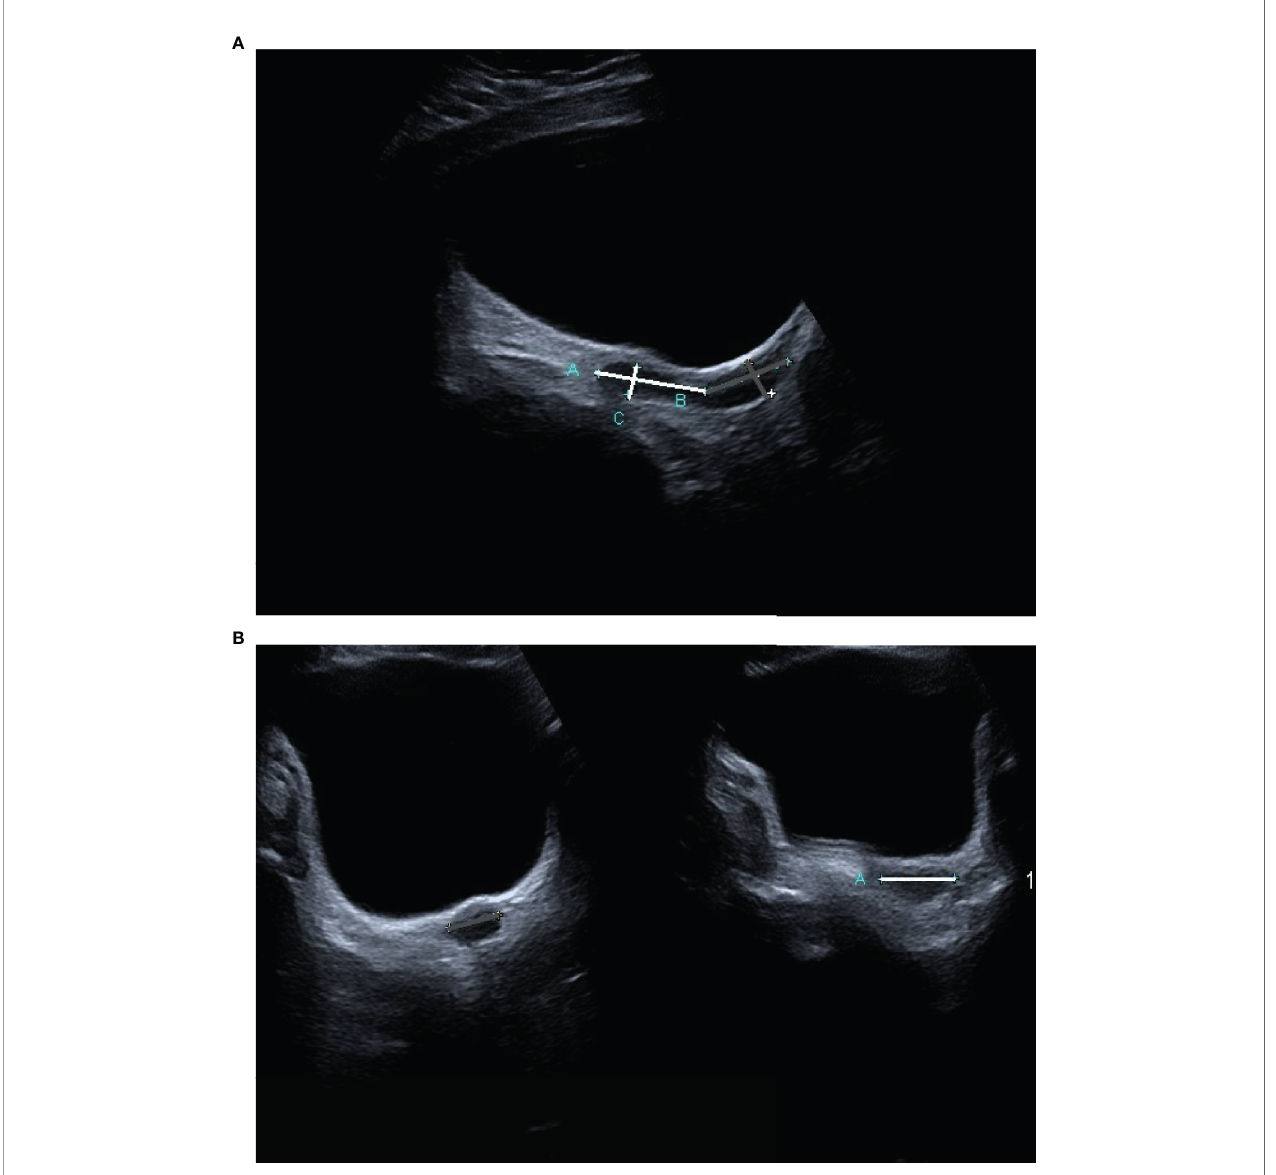
FIGURE 1 | A transabdominal ultrasound image of the uterus in a TS patient prior to the beginning of ERT (A) longitudinal projection, (B) transverse projection). The measurements of the uterine body are marked white, and those of the cervix are marked